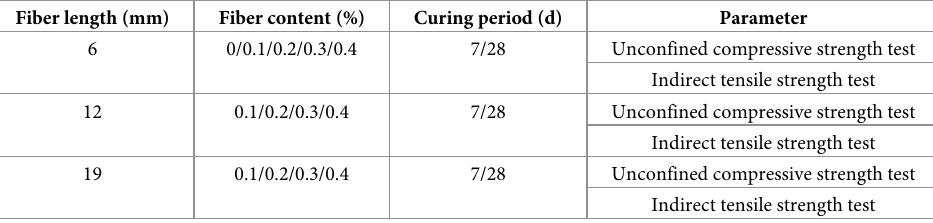
Table 4. Proportions of